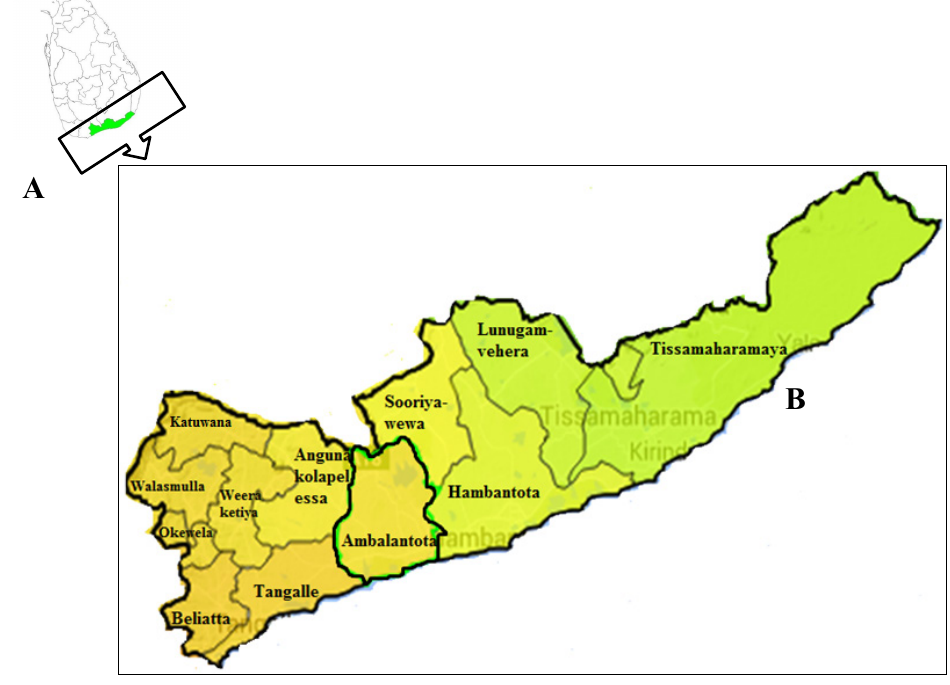
Figure 1: A: Map of Sri Lanka with Hambantota district shaded. B: District Secretary Divisions in Hambantota